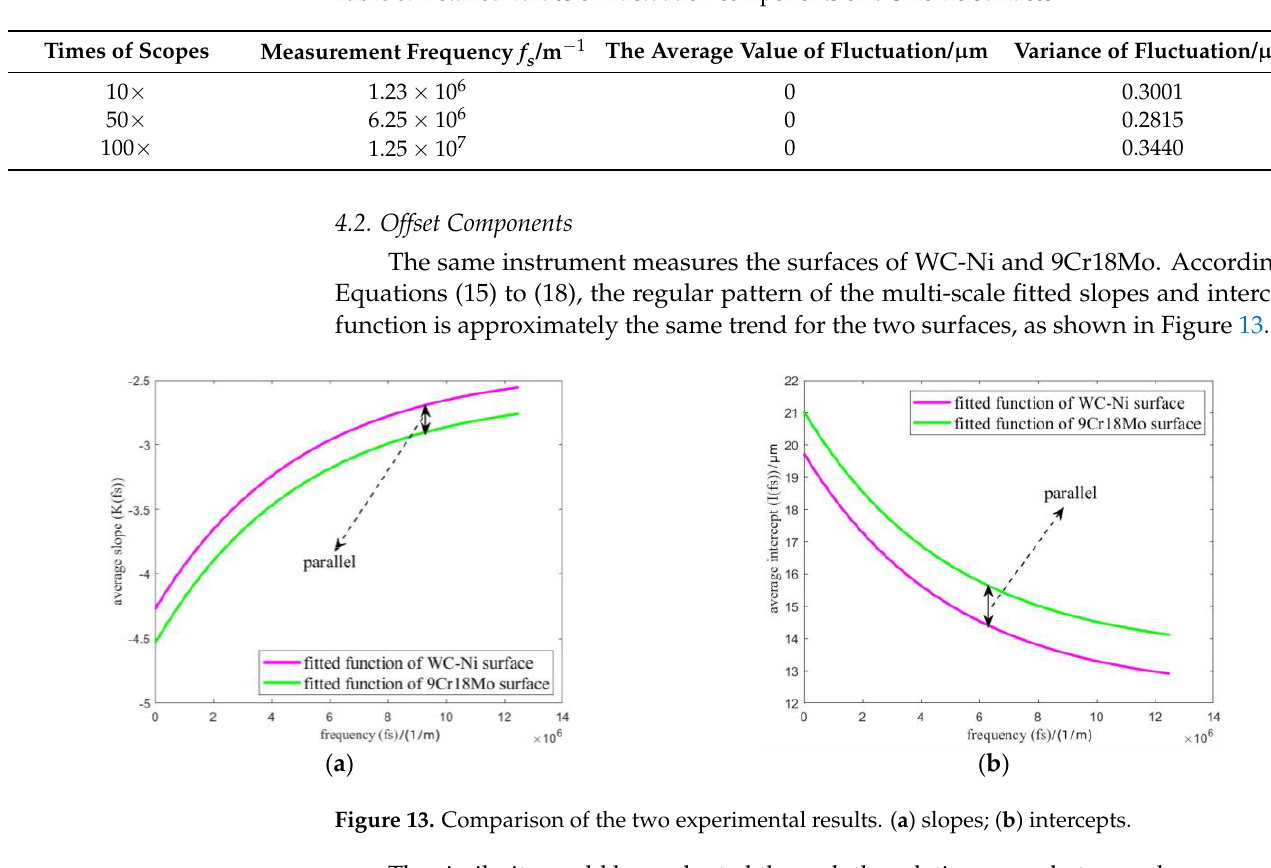
Table 8. Detailed values of fluctuation components on 9Cr18Mo surfaces.